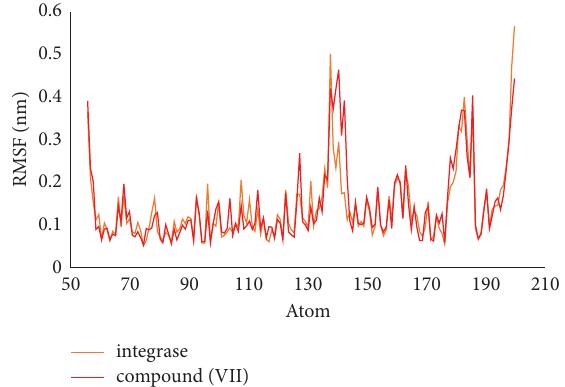
Figure 9: Graph of RMSF changes of alpha carbon integrase according to residue in connection with compound VII at 100ns and 300K. RMSF of integrase is in orange, and in the presence of compound VII, it is in